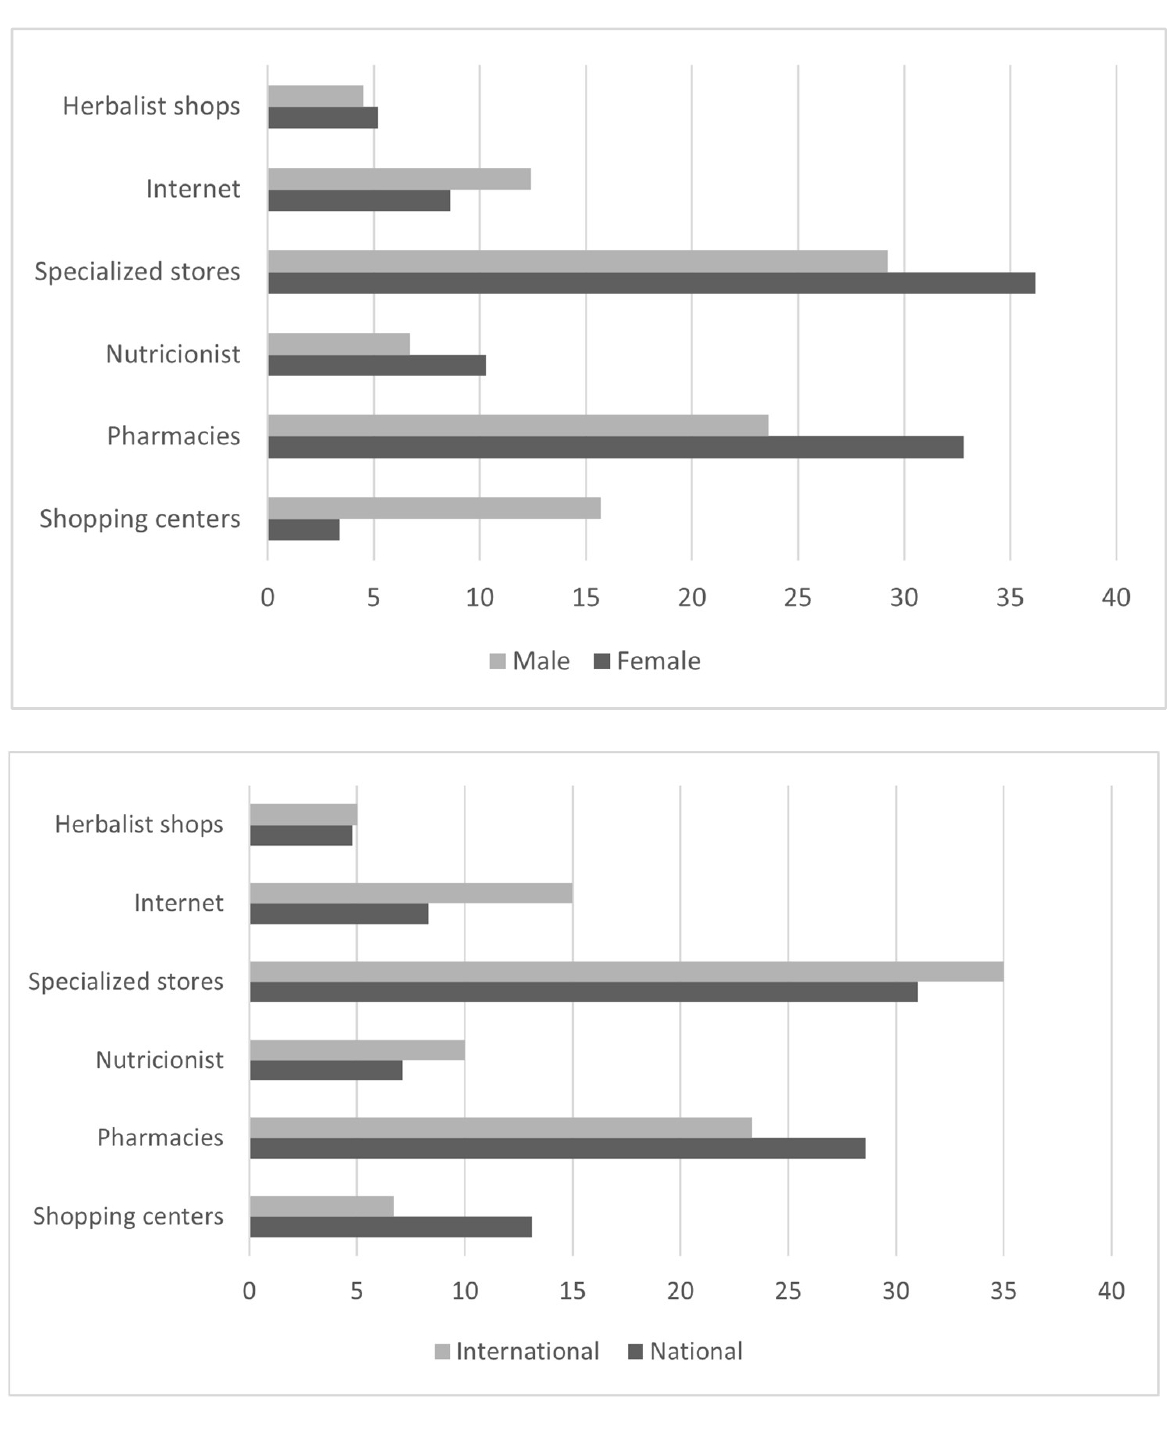
Figure 1. Main site of supplement purchase by elite swimmers according to sex ( up ) and competitive level ( down ).